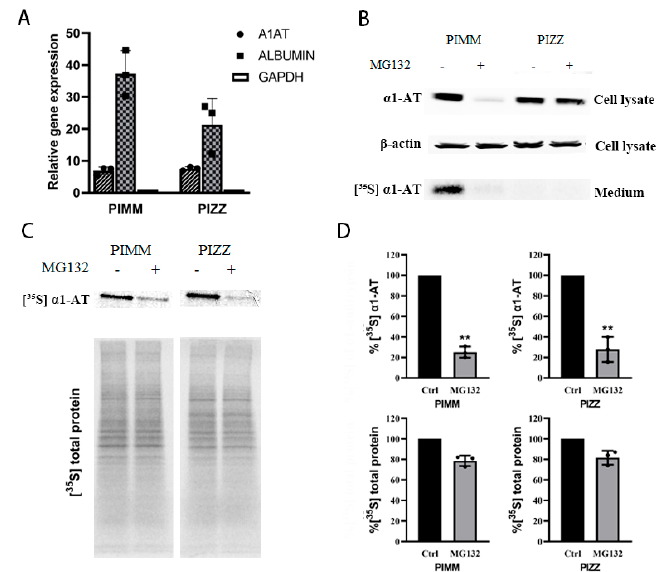
Figure 7. Proteasome inhibitors reduced wild type and mutant α 1AT expression in human iPSC-derived hepatocytes. ( A ) Normal (PIMM) and α 1ATD patient (PIZZ) inducible pluripotent stem cells were differentiatedintohepatocytes; cellular albuminand α 1AT mRNAwereevaluatedby qPCR.( B ) PIMM and PIZZ iPSC-hepatic cells were treated with or without MG132 (10 µ m) for 4 h and labeled with [ 35 S] methionine / cysteine for 30 min. The steady stage of synthesized α 1AT (PIMM) and α 1ATZ (PIZZ) were detected by western blotting. Secreted α 1AT from culture media was immunoprecipitated and detected by autoradiography. ( C , D ) [ 35 S] labeled synthesized cellular α 1AT, α 1ATZ and general protein were detected by autoradiography and quantitatively analyzed. Data represent means ± SD of three independent experiments. ** p <